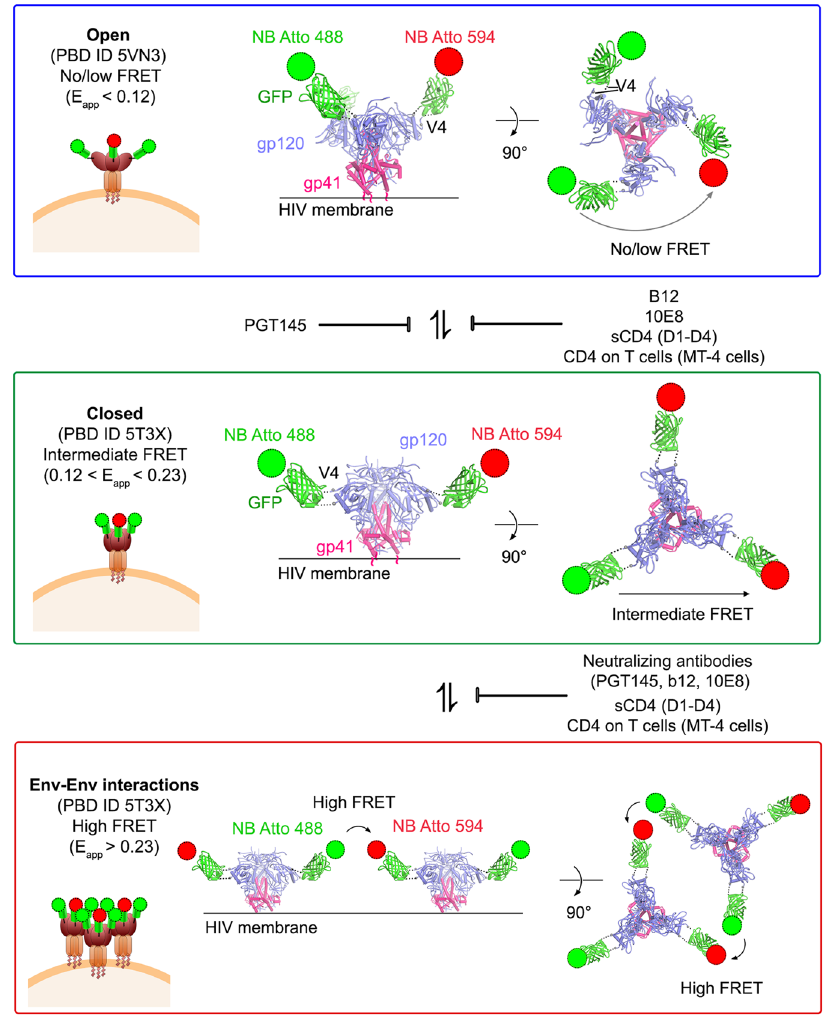
Fig. 5 HIV-1 Env transitions between intra- and intermolecular conformations are disrupted by CD4-binding and bNAbs. Schematic representation of the transitions between different intra- (open, showing low/no FRET, upper panel; closed, showing moderate FRET, middle panel) and intermolecular (cluster, showing high FRET bottom panel) Env conformations observed by FRET-FLIM. Receptor binding (sCD4 D1-D2 or CD4 on T cells) and binding of b12 and 10E8 bNAbs stabilize and intermediate or open conformation, whereas PGT145 favors a closed conformation. Engagement of Env with CD4 or with any of bNAbs tested increases the distance between Env molecules, inducing Env-Env